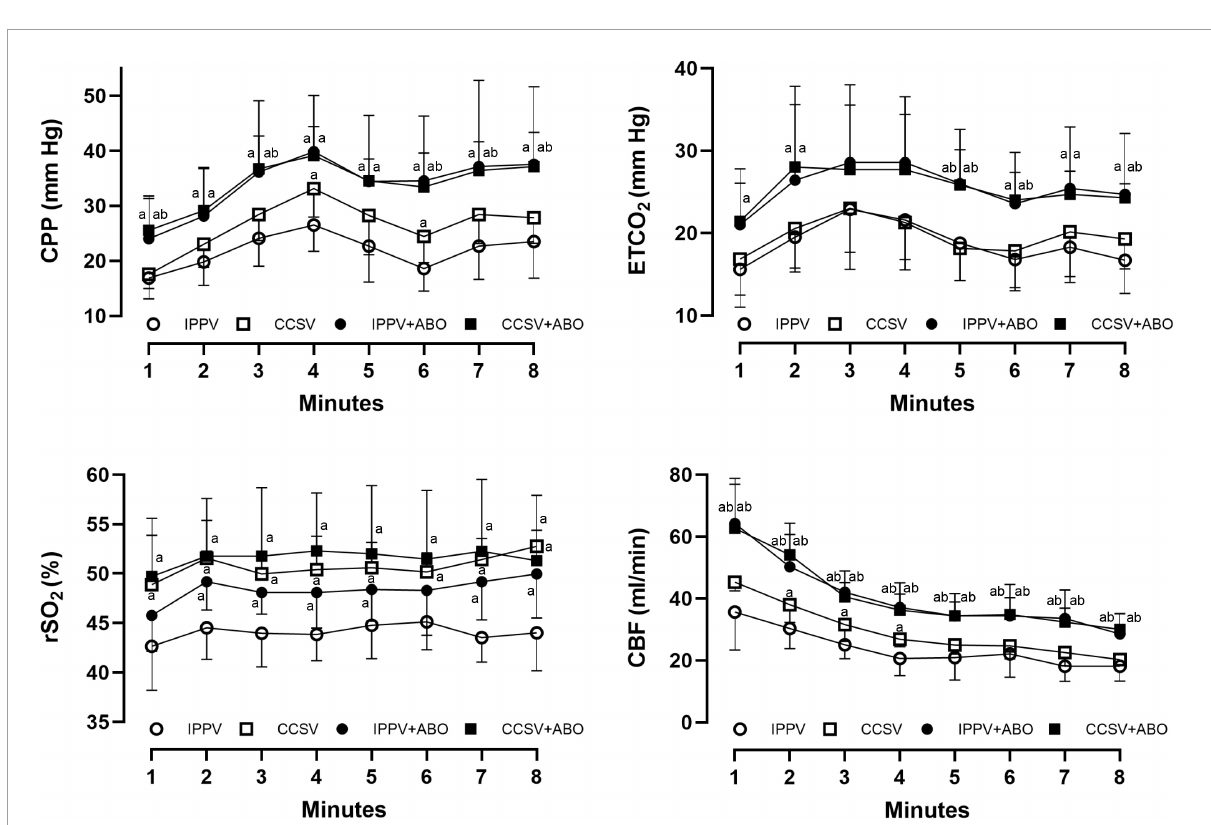
FIGURE2 The changes of coronary perfusion pressure (CPP), end-tidal carbon dioxide (ETCO 2 ), regional cerebral oxygen saturation (rSO 2 ), and carotid blood flow (CBF) during cardiopulmonary resuscitation (CPR). IPPV, intermittent positive pressure ventilation; CCSV, chest compression synchronized ventilation; ABO, aortic balloon occlusion. Each group contained 7–10 swine during CPR. a P < 0.05 for CCSV + ABO group, IPPV + ABO group, CCSV group vs. IPPV group; b P < 0.05 for CCSV + ABO group (right b), IPPV + ABO group (left b) vs. CCSV group.